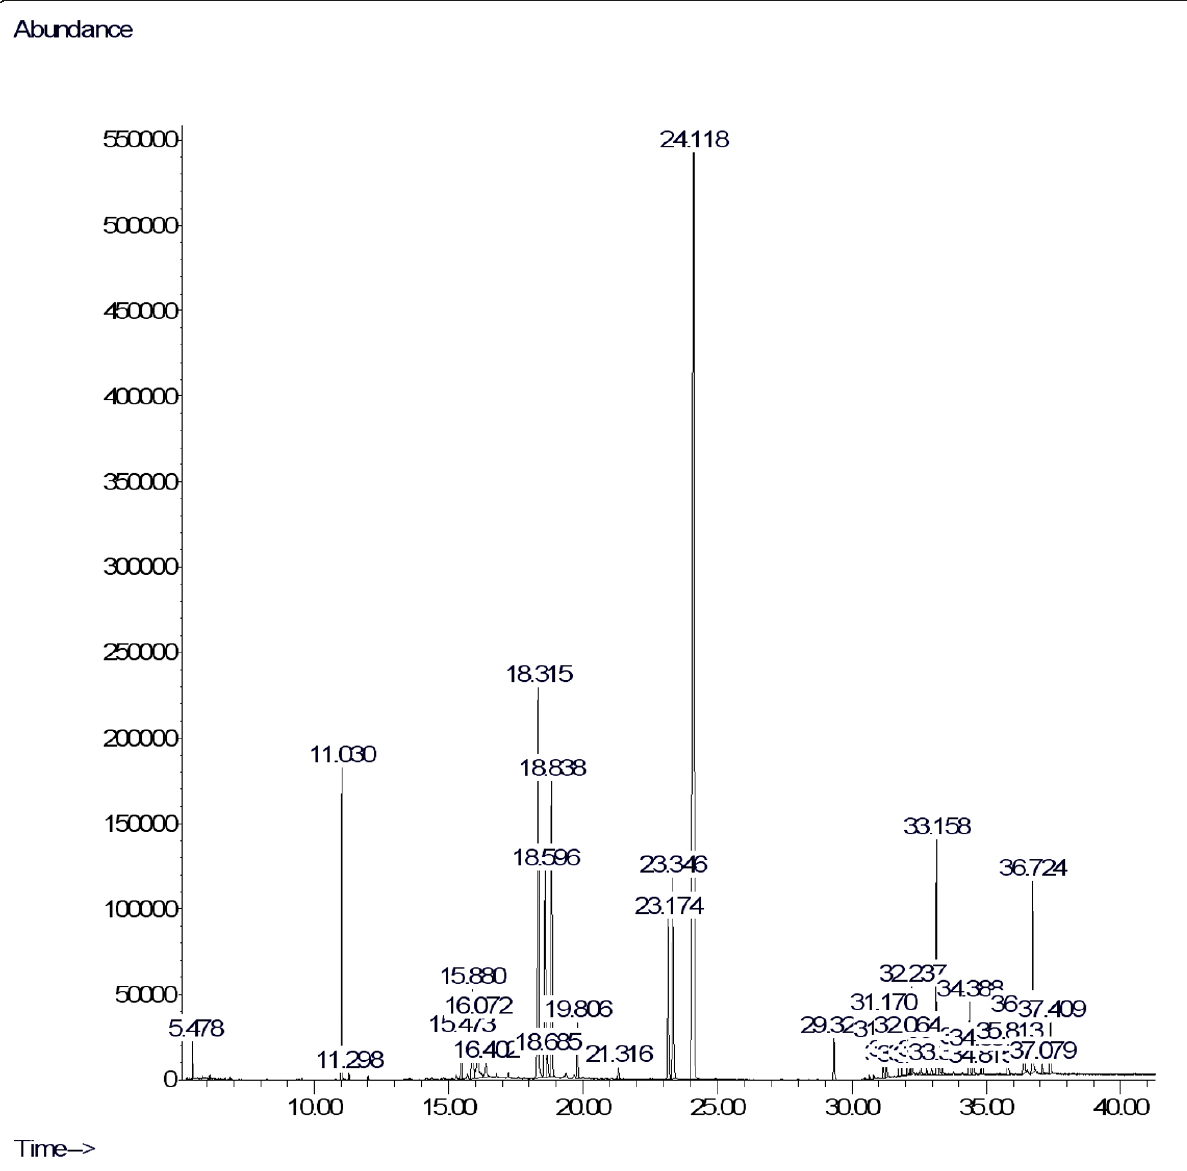
Figure 3 Chromatogram obtained from GC-MS with the methanolic extracts of the flowers of P. venusta